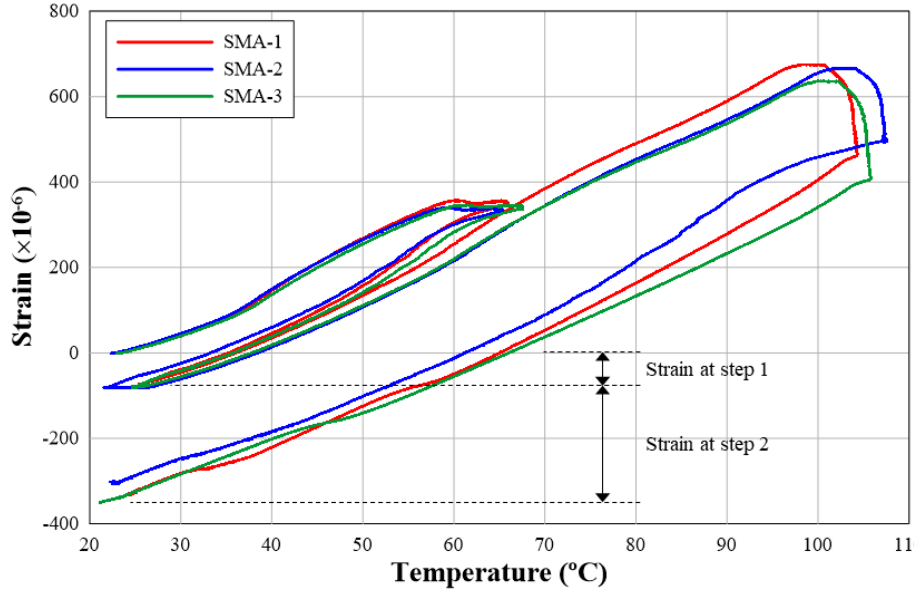
Figure 17. Simultaneously plotted strain-temperature curve.